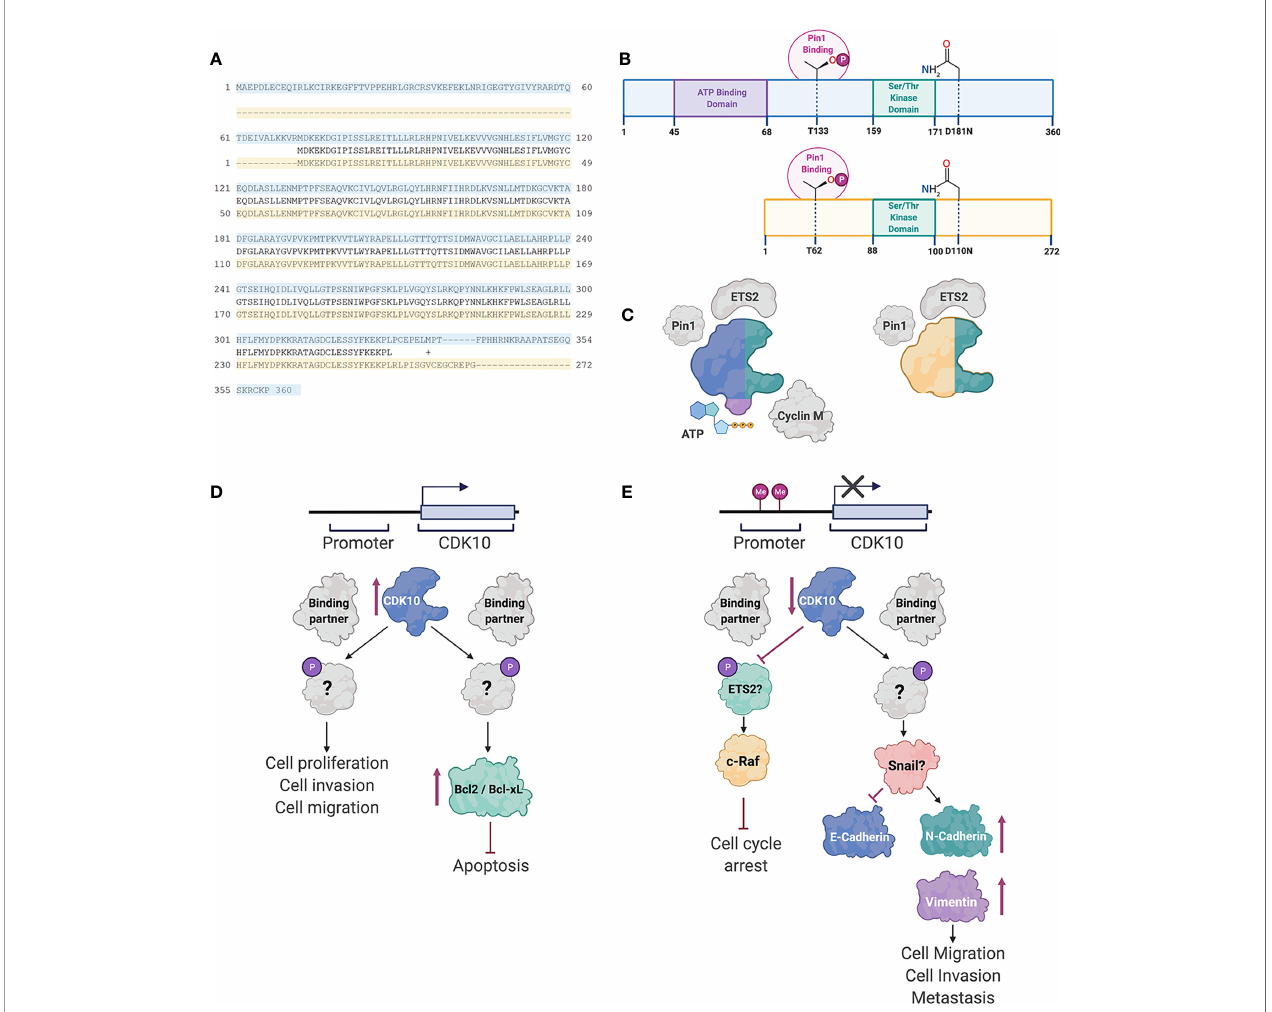
FIGURE 1 | CDK10 isoforms and interacting partners. (A) Protein sequence alignment of the full length CDK10 isoform (blue) and the splice variant (yellow). (B) Schematics of the full length CDK10 isoform and splice isoform, showing the ATP binding domain, the Ser/Thr kinase domain and Thr133, which is involved in Pin1 binding. (C) Models of CDK10 full-length protein and splice isoform with putative binding partners. Figures were created using BioRender. (D) Proposed CDK10 oncogenic signaling pathways. (E) Proposed CDK10 tumor suppressive signaling pathways. “ ? ” denotes not yet shown in gastrointestinal and hepatobiliary cancers (60, 62 –